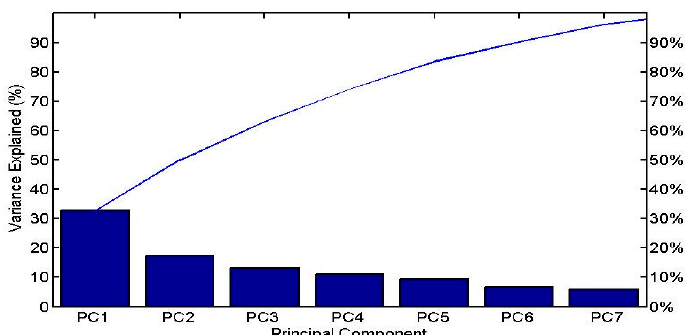
Figure 3. Pareto chart representing the percentage of variance explained by the principal components (PCs) of the PCA analysis.